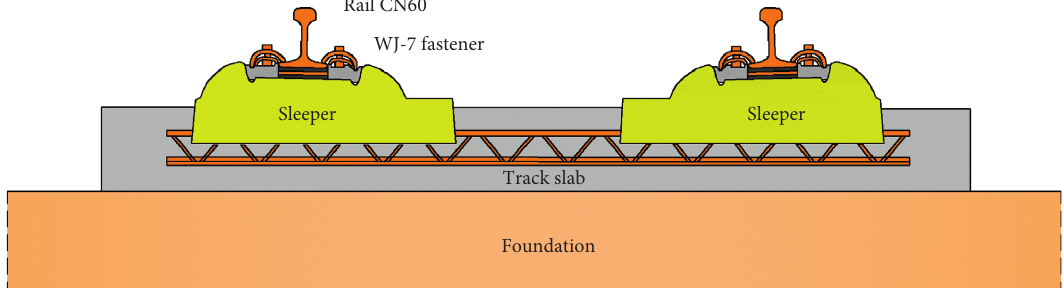
Figure 1: Diagram of CRTS I bi-block ballastless track in